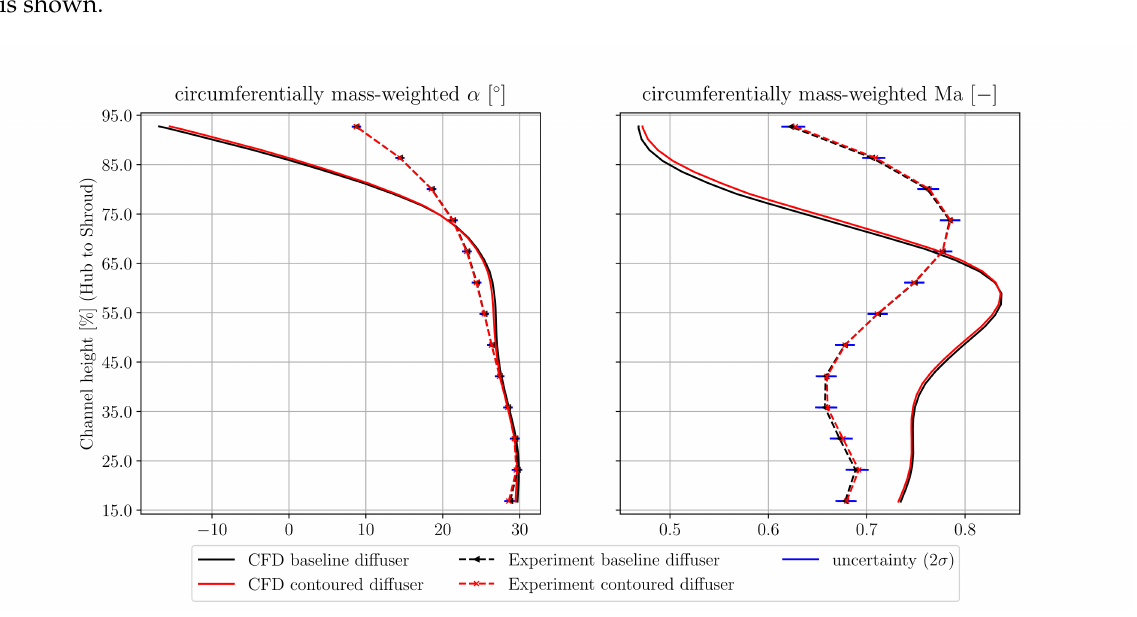
Figure 5. Comparison of circumferentially mass-weighted circumferential flow angle α and local Mach number at operating point near stability limit at Mu 2 =